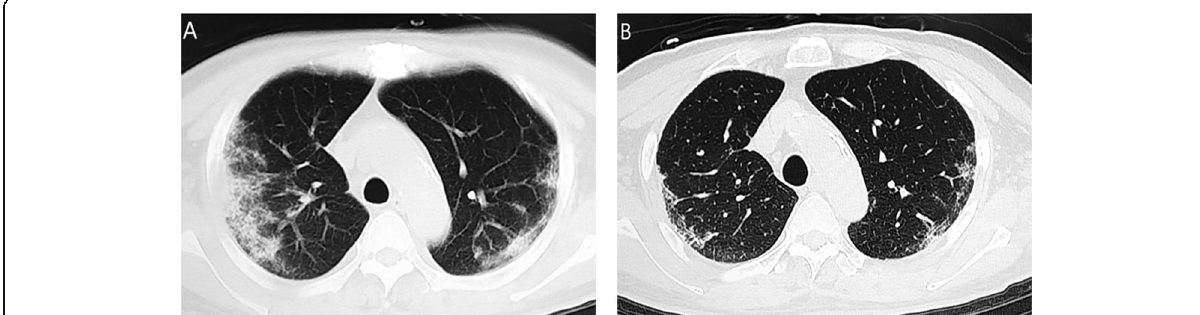
Fig. 2 a CT scan obtained on the first day showed multifocal bilateral ground-glass opacities and consolidative pulmonary opacities. b CT